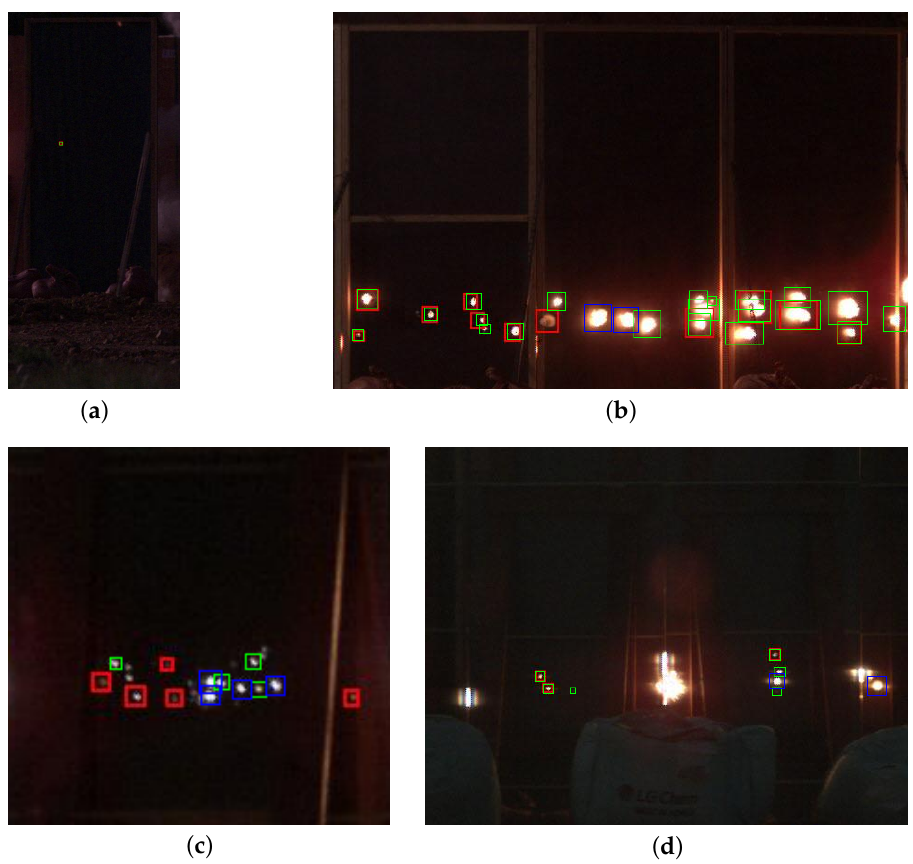
Figure 14. The qualitative results of the sample images shown in Figure 13. ( a ) Case 1. ( b ) Case 2. ( c ) Case 3. ( d ) Case